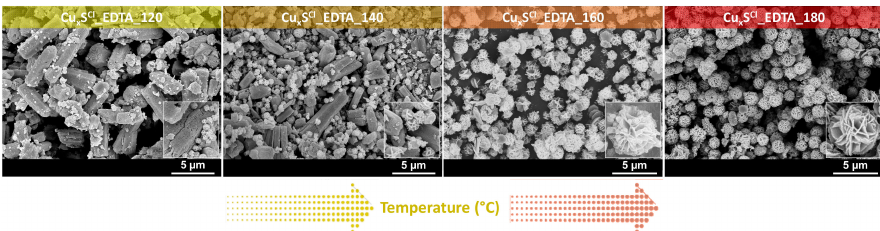
Figure 1. E ff ect of the increasing of the synthesis temperature (from 120 to 180 ◦ C) on particle morphology and dispersity using CuCl 2 as the precursor salt and EDTA as the stabilizing agent.